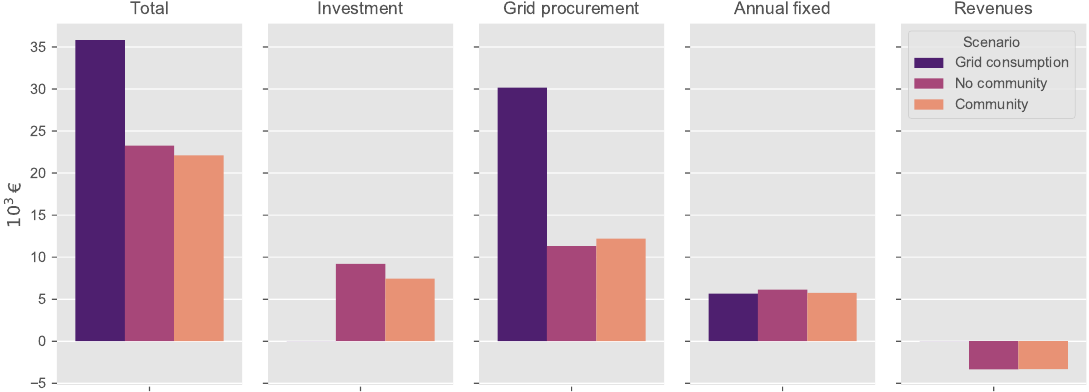
Figure 5. Disaggregation of total costs on the example of Portugal, demand scenario